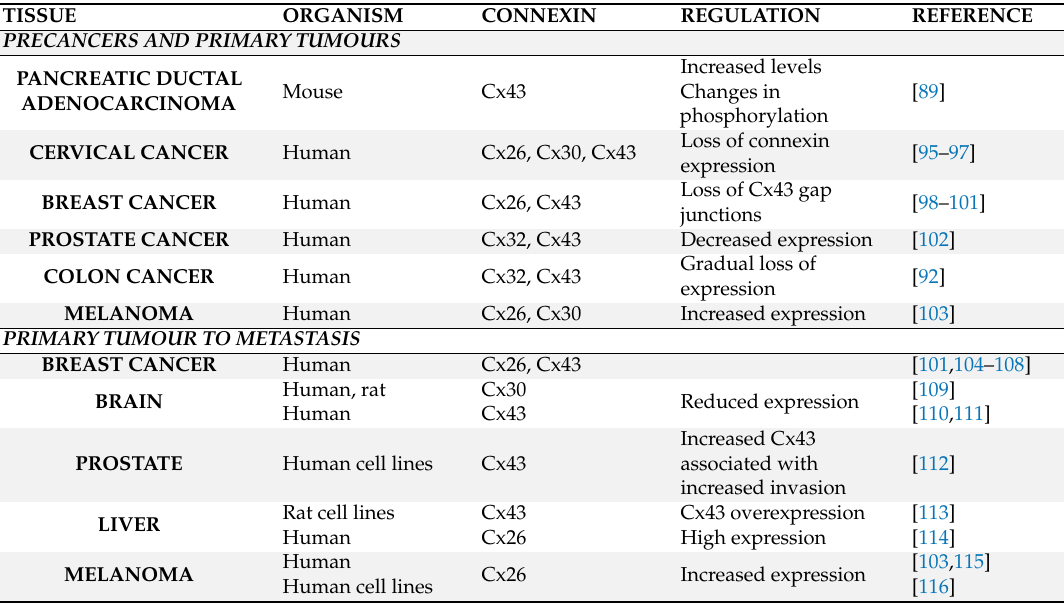
Table 1. Selected representative examples of changes in connexins during tumour progression and metastasis.